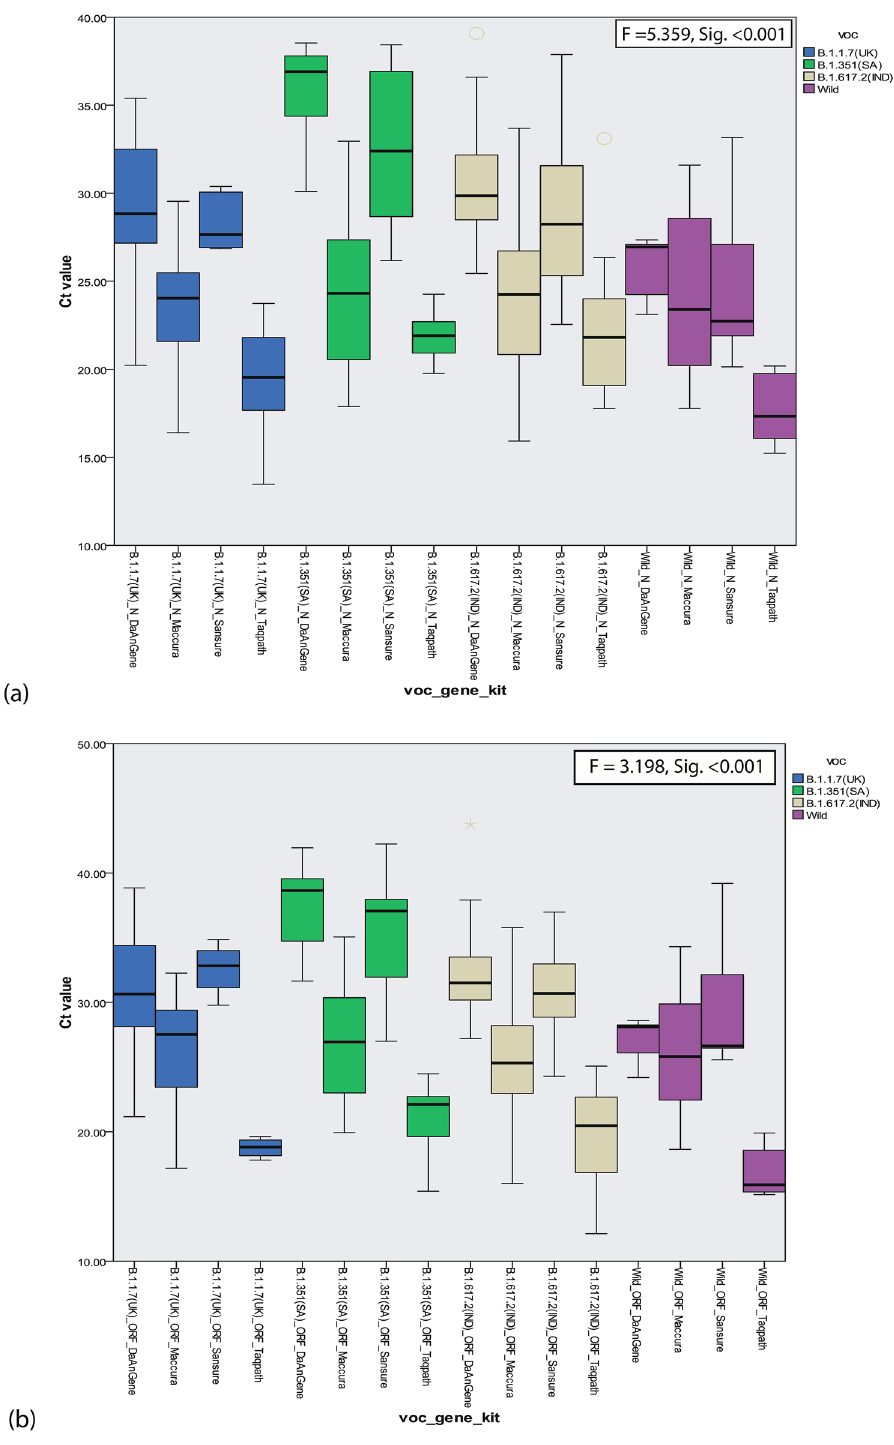
Figure 5. Boxplot showing Ct value reported by variant of concern for target genes of different kits. ( a ) Boxplot of Ct value reported for N-Gene by different Variants of Concern (VOC) in different RT-PCR kits. ( b ) Boxplot of Ct value reported for ORF-Gene by different Variants of Concern (VOCs) in different RT-PCR